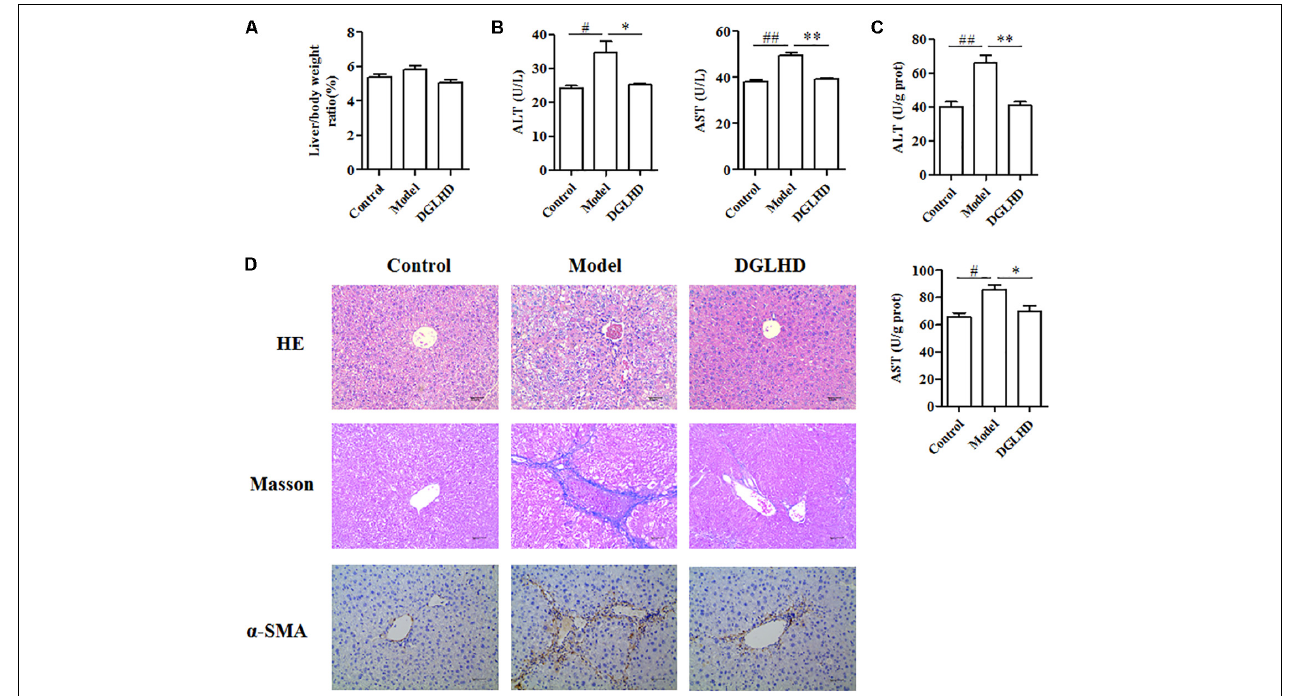
FIGURE 4 | Dangguiliuhuang decoction ameliorated hepatic fibrosis in CCl 4 -induced fibrotic mice. C57BL/6J mice were administrated daily with water or DGLHD at 5.0 g/kg by intragastric gavage for 6 weeks ( n = 8 for each group). (A) The ratio of liver weight to body weight. (B) Concentrations of ALT and AST in serum. (C) Concentrations of ALT and AST in liver homogenate. (D) Representative images of liver sections stained with hematoxylin-eosin or Masson or α -SMA antibody (magnification, 200 × ). Data are shown as mean ± SEM ( n = 4–5). # P < 0.05, ## P < 0.01 compared to Control. ∗ P < 0.05, ∗∗ P < 0.01 compared to